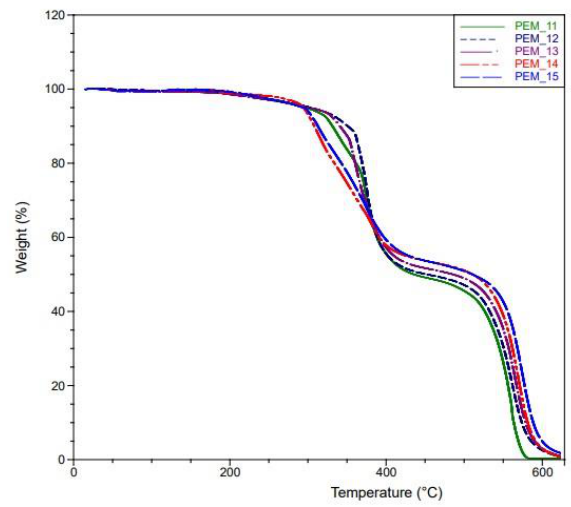
Figure 7. TGA curves of PEM_11–PEM_15.